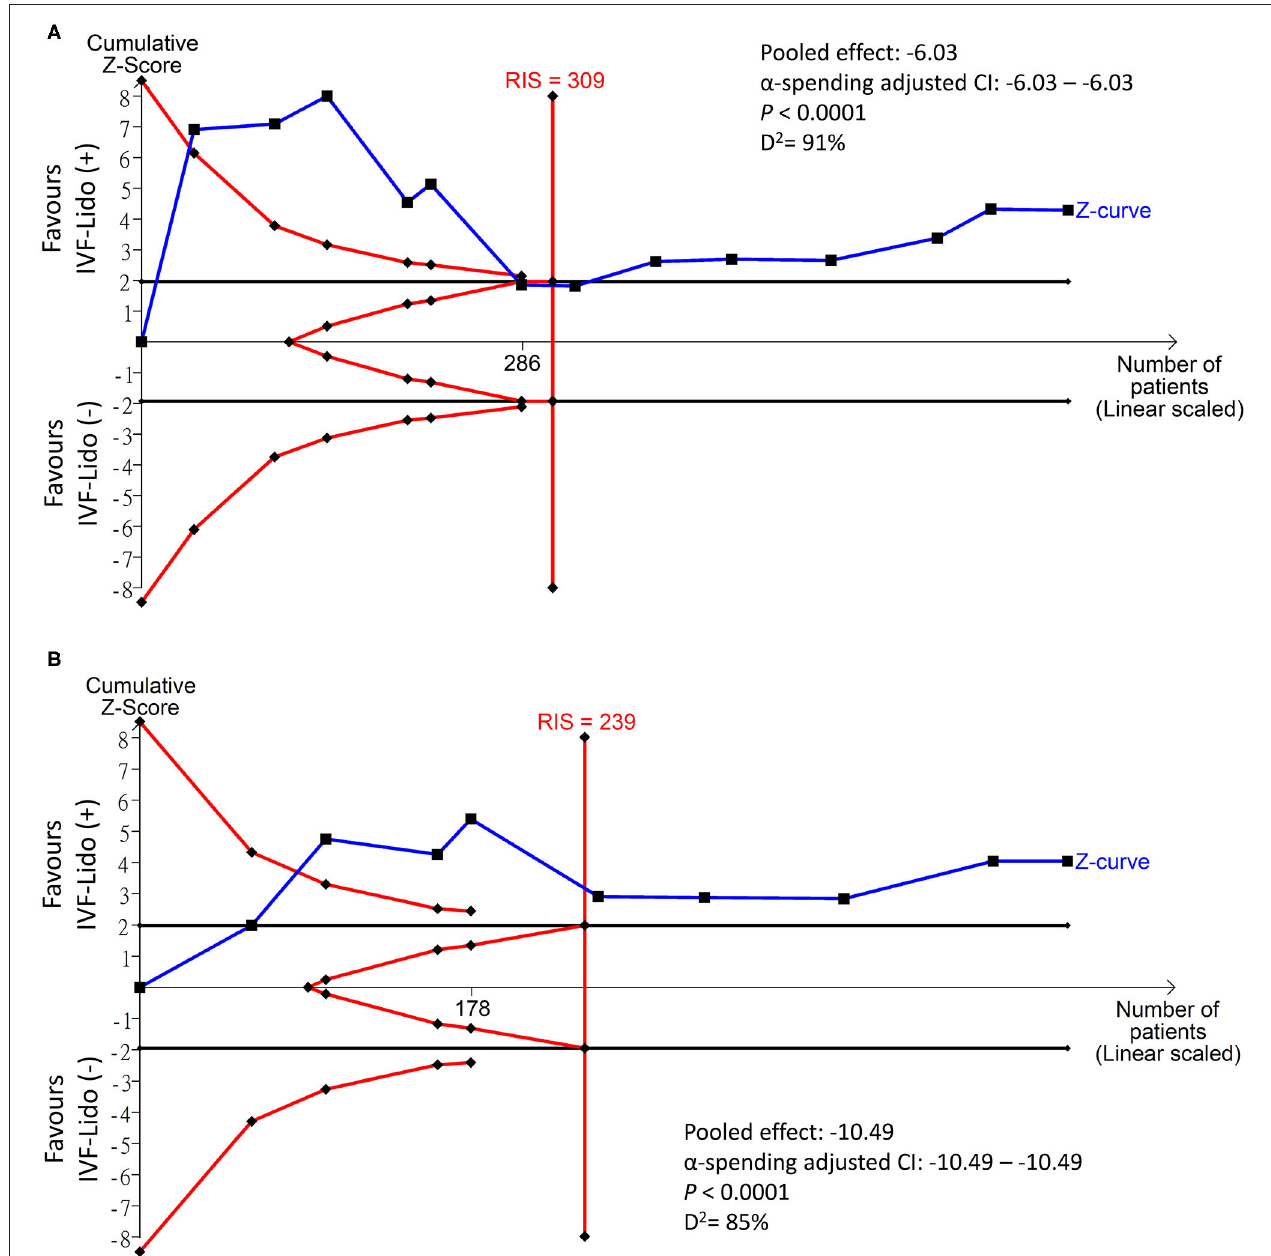
FIGURE 4 | Trial sequential analysis in the time (hours) to (A) first flatus and (B) defecation. IVF-Lido, intravenous infusion of lidocaine; RIS, required information